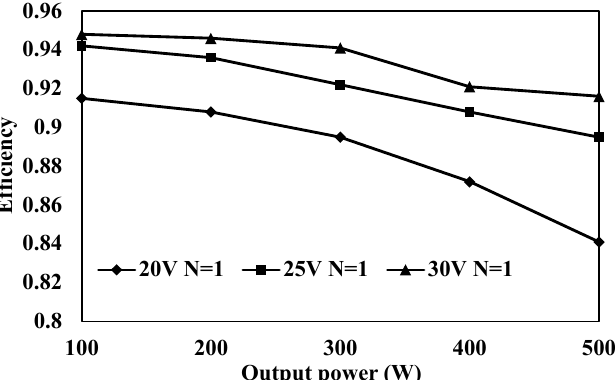
Figure 13. Measured efficiencies at different loads.